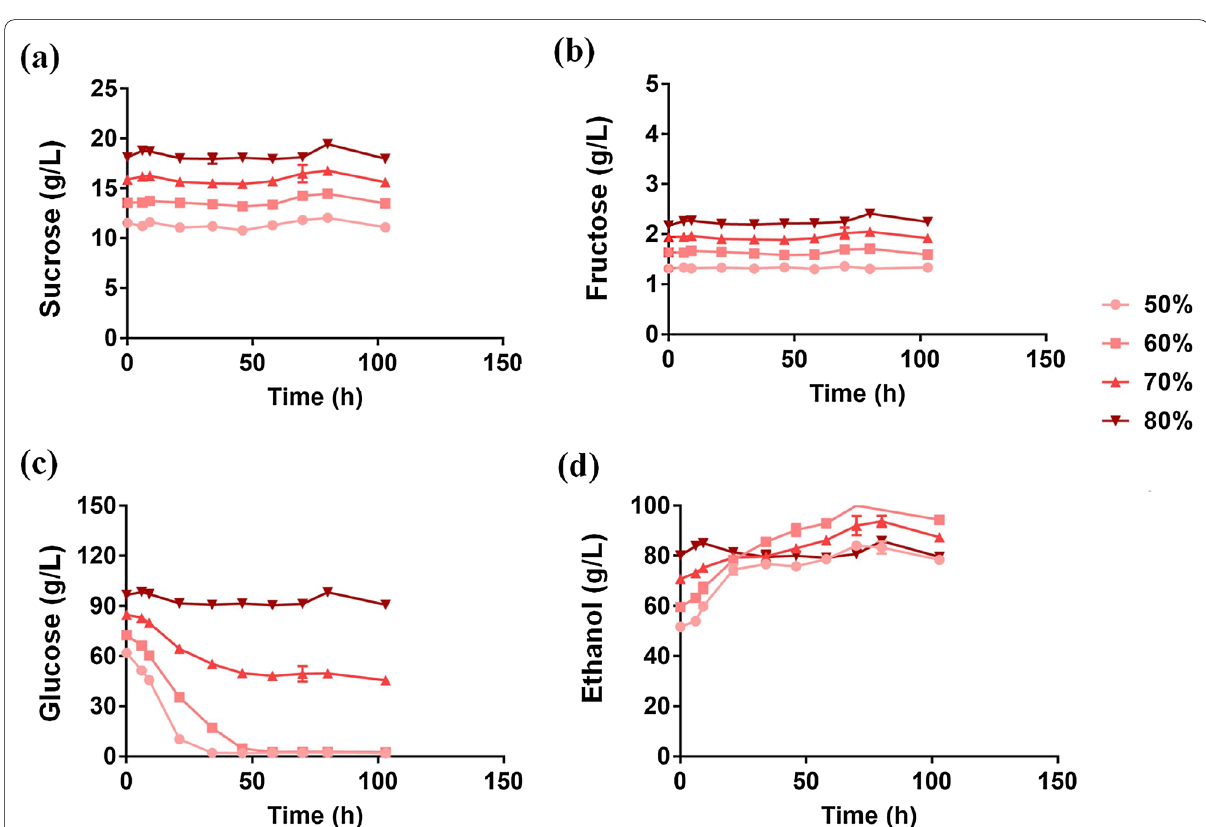
Fig. 5 Concentration changes of sucrose ( a ), fructose ( b ), glucose ( c ), and ethanol ( d ) during fermentation by Z. mobilis in Chinese traditional wine (CTW) with the dilution rates of 50% (circle), 60% (square), 70% (triangle), and 80% (inverted triangle), respectively. There were significant differences for glucose consumption ( p- value < 0.0001) and ethanol production ( p- value 0.035) in 50%, 60%, 70%, and 80% CTW using one-way =